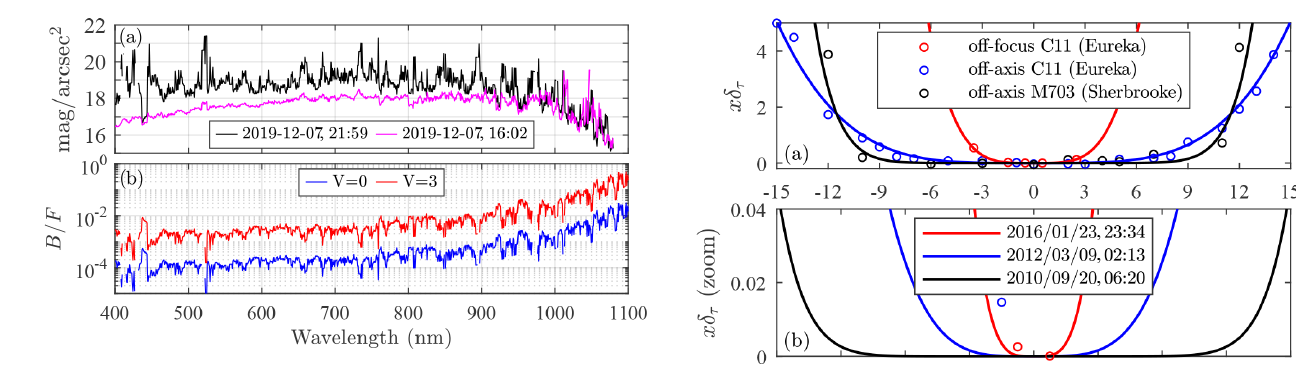
Figure 16. (a) Night sky background spectrum, measured with the Eureka SPST09/C11 (in the Pulkovo catalogue photometric system) at midday (magenta curve) and in the evening (black curve) during polar night. (b) Ratio of background to star flux for the evening sky and for two star magnitudes: Vega at V = 0 (blue curve) and a dimmed Vega at V = 3 (red curve). Times are UTC.